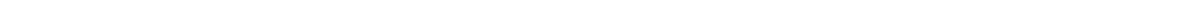
Fig. 2 Binding of a non-hydrolysable GTP analogue (GppNHp) to the Chlorobium tepidum Roco protein shifts the equilibrium toward the monomeric form. a Scattering curves of CtRoco in the absence ( black dots ) or presence of nucleotides GDP ( green dots ) or GppNHp ( red dots ). b Superposition of the crystallographic CtRoc-COR dimer model (Roc in red and COR in blue ) onto the ab initio SAXS envelope, constructed starting from the scattering curve of CtRoco in the absence of nucleotides. The envelope shows clear additional features corresponding to the N-terminal LRR domain and the C-terminal domain, which are not present in the CtRoc-COR crystal structure. c Overview of the molecular masses obtained via SAXS (based on Porod volume/1.7), SEC-MALS and SV-AUC for CtRoco in different nucleotide-bound states. The theoretical molecular mass of the monomer is given in between brackets. (NF = nucleotide-free) d SEC-MALS data for CtRoco in the absence ( black ) or presence of nucleotides GDP ( green ) or GppNHp ( red ). e Native mass spectra of CtRoco for the three different nucleotide states: nucleotide-free (NF), GDP-bound and GppNHp-bound. Peaks corresponding to dimeric and monomeric species are labeled with two circles and one circle , respectively. f Top panels : negative-stain EM images ( scale bar : 50 nm) of CtRoco in the nucleotide-free state ( black border ), bound to GDP ( green border ) or bound to GppNHp ( red border ). Middle panels : 4x enlargements of boxed particles in top panels (from left to right ). Bottom panels : representative class averages (box size: 18.2 × 18.2 nm) for CtRoco in nucleotide-free state ( black border ), or bound to GDP ( green border ) or GppNHp ( red border ). See also Supplementary Fig. 7 for an overview of all class